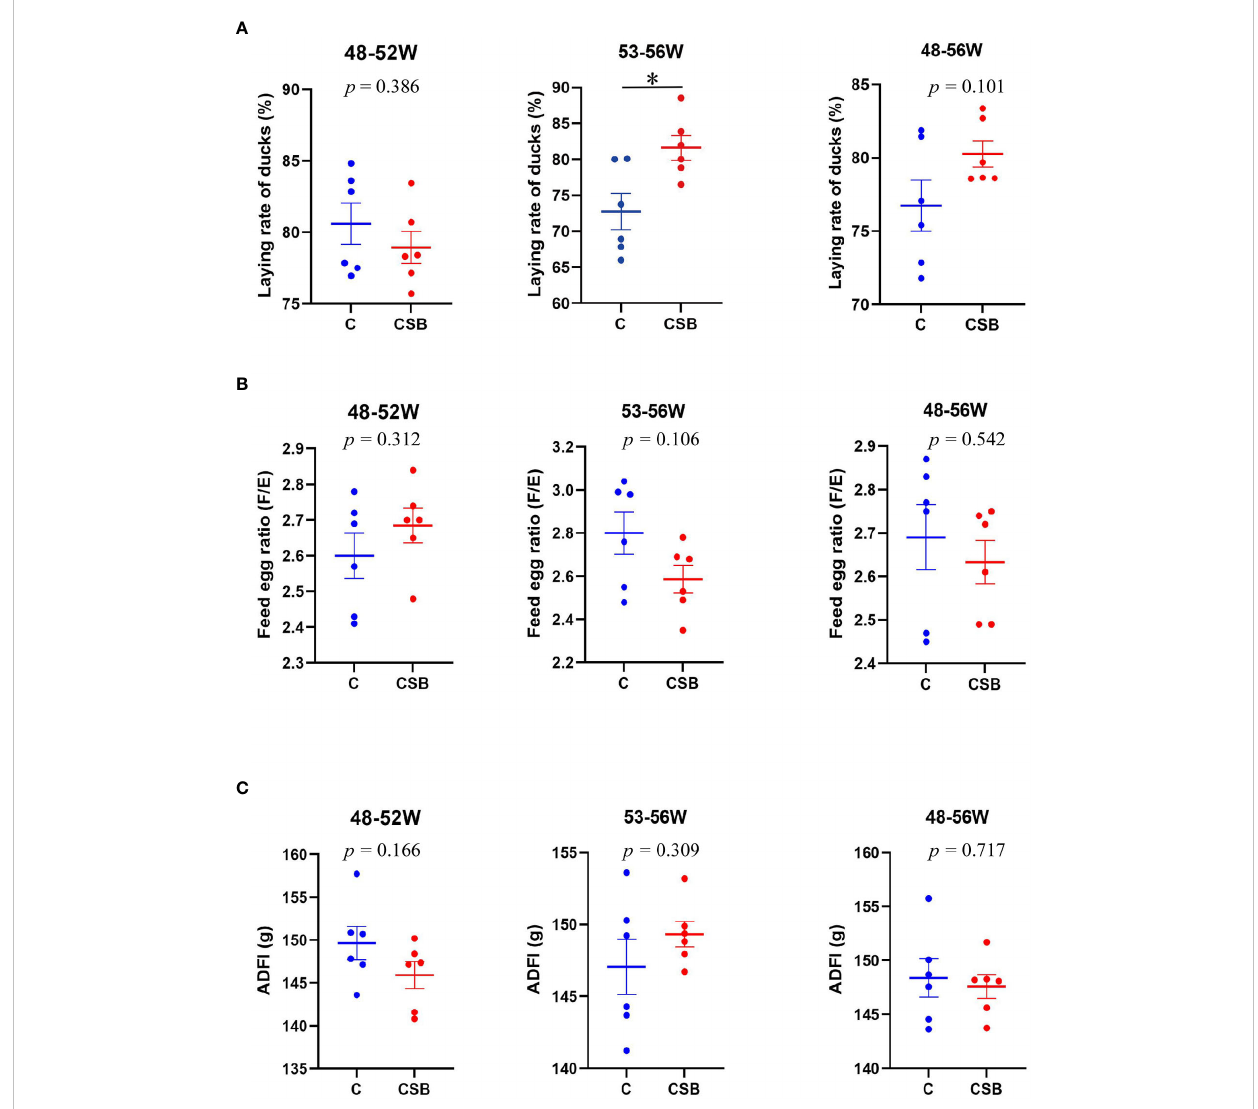
FIGURE 1 Effects of dietary supplementation of coated sodium butyrate (CSB) on the growth performance of laying ducks. (A) Laying rate of different times laying ducks. (B) Feed-to-egg ratio (F/E) of different times laying ducks. (C) Average daily feed intake (ADFI) of different times laying ducks. Values are presented as means ± SEM (n = 6). * p< 0.05. group C, Control group, which was fed a basal diet; CSB group, CSB-treated group, which was fed the basal diet supplemented with 250 g/t of